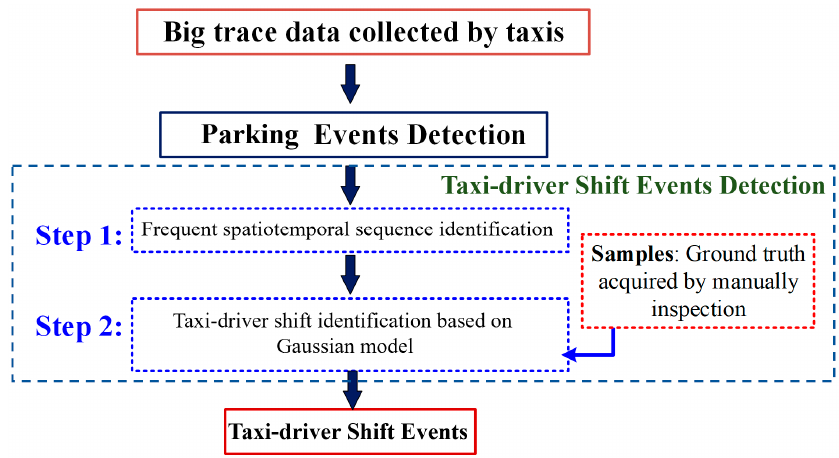
Figure 1. Architecture of taxi-driver shift event detection based on big trace data.